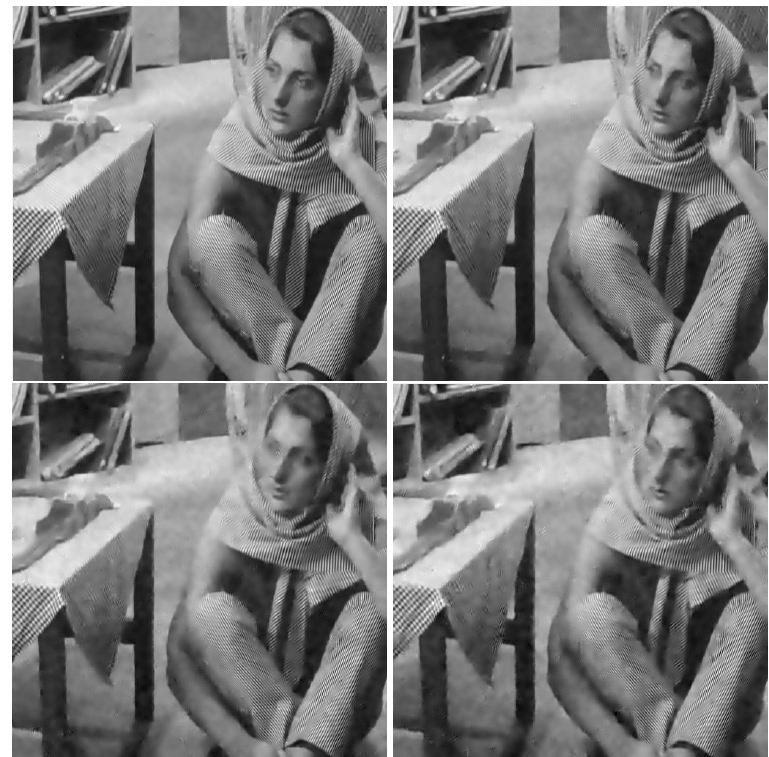
Figure 3. Reconstruction of barbara using DRTPF ( left ) and K-SVD [14] ( right ). Top: σ = 30; bottom: σ =